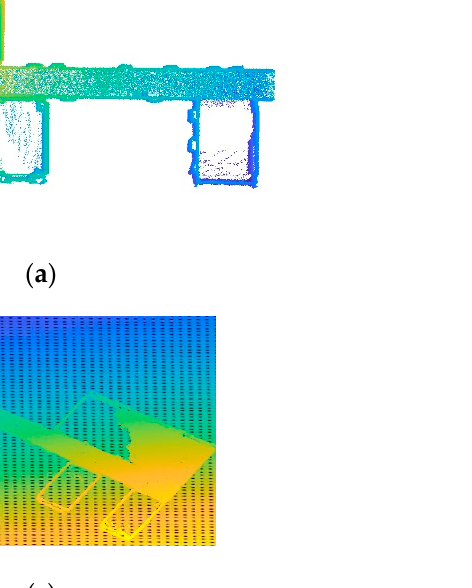
Ω is a cuboid Ο